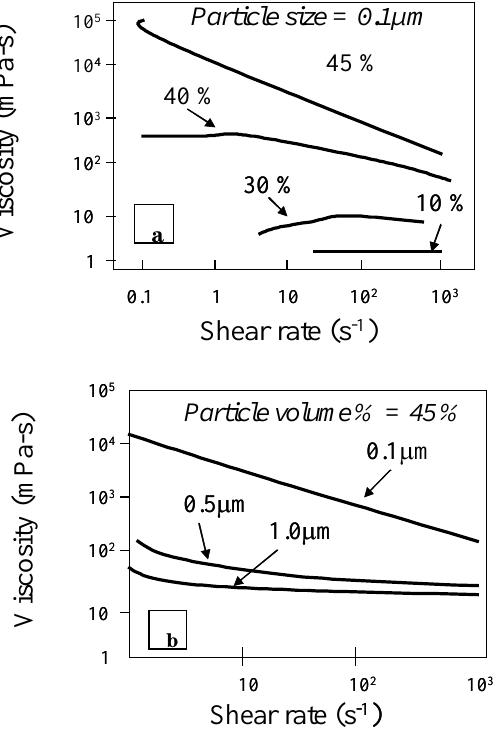
Fig.7 Viscosity as a function of shear rates for silica dispersion a) 0.1 µ m abrasives at different volume percent and b) 45 % (vol) abrasives of different sizes (Redrawn from Fig.3 and 4 in [17)] requested permission from Taylor and